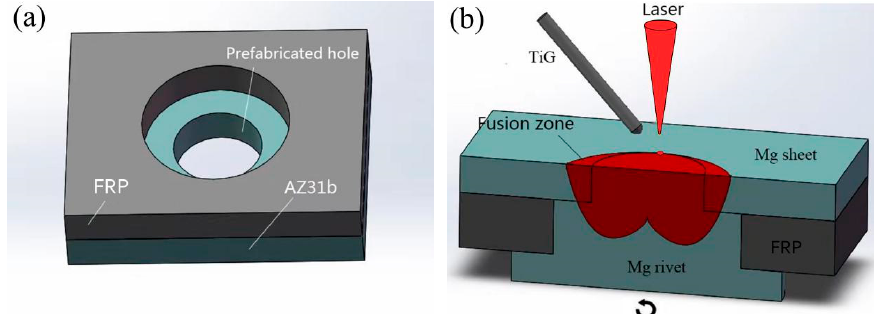
Figure 2. The schematic diagram of the hybrid welding process. ( a ) prefabricated hole in Mg and Fiber Reinforced Polymer (FRP) and ( b ) laser-TIG hybrid welding process. Table 2. Hybrid welding parameters.